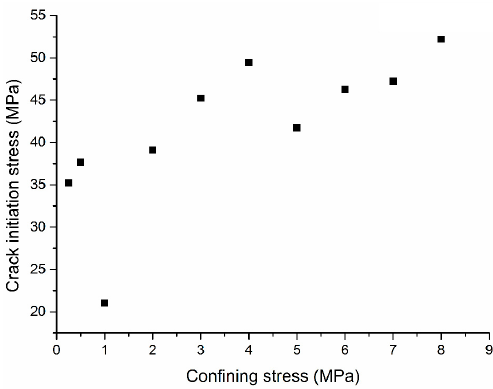
Figure 18. Crack initiation stress for coal specimens of group 1 under different confining